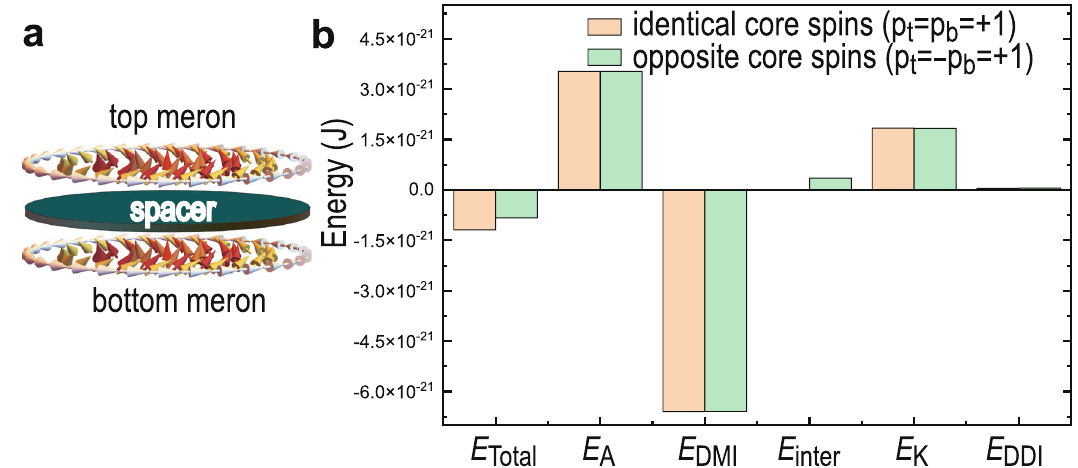
Fig. 5 The Ising interaction between two merons. a Schematic illustration for the Ising interaction between two merons. Dark green cylinders represent a spacer. b The contribution of different energy terms to the total energy E Total of a relaxed exchange-coupled bilayer meron with identical or opposite core- spin direction, including the intralayer exchange energy E A , DMI energy E DMI , interlayer exchange energy E Inter , anisotropy energy E K , and dipole – dipole interaction (DDI) energy E DDI . The total energy difference for the exchange-coupled bilayer merons with identical and opposite core-spin directions equals 3.6 × 10 − 22 J. The radius of the meron is n = 7, and we have used A Inter = 0.005 pJ m − 1 . The simulation parameters are given in the caption of Fig. 2. More details are given in the “ Methods ”